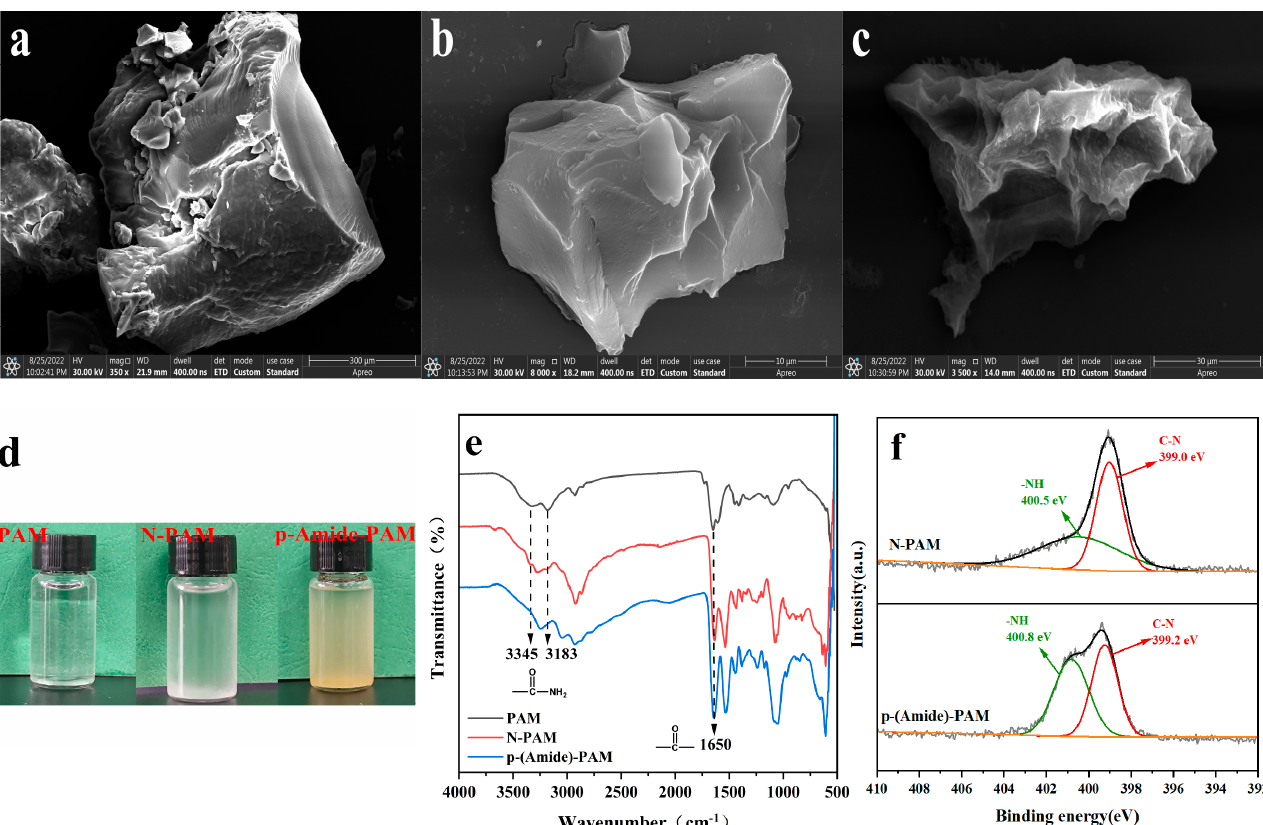
Figure 2. SEM images of PAM ( a ), N-PAM (b), and p-(Amide)-PAM ( c ); dispersion of PAM, N-PAM, and p-(Amide)-PAM in water ( d ); FT-IR spectrum of PAM, N-PAM, and p-(Amide)-PAM ( e ); and XPS N 1s spectrum of N-PAM and p-(Amide)-PAM ( f ). Table 1. The elemental content of PAM, N-PAM, and